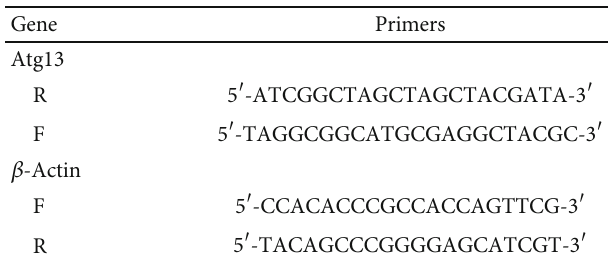
Table 2: Primers used in